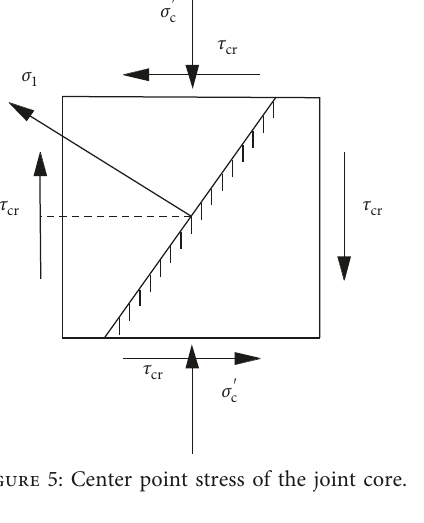
Figure 5: Center point stress of the joint